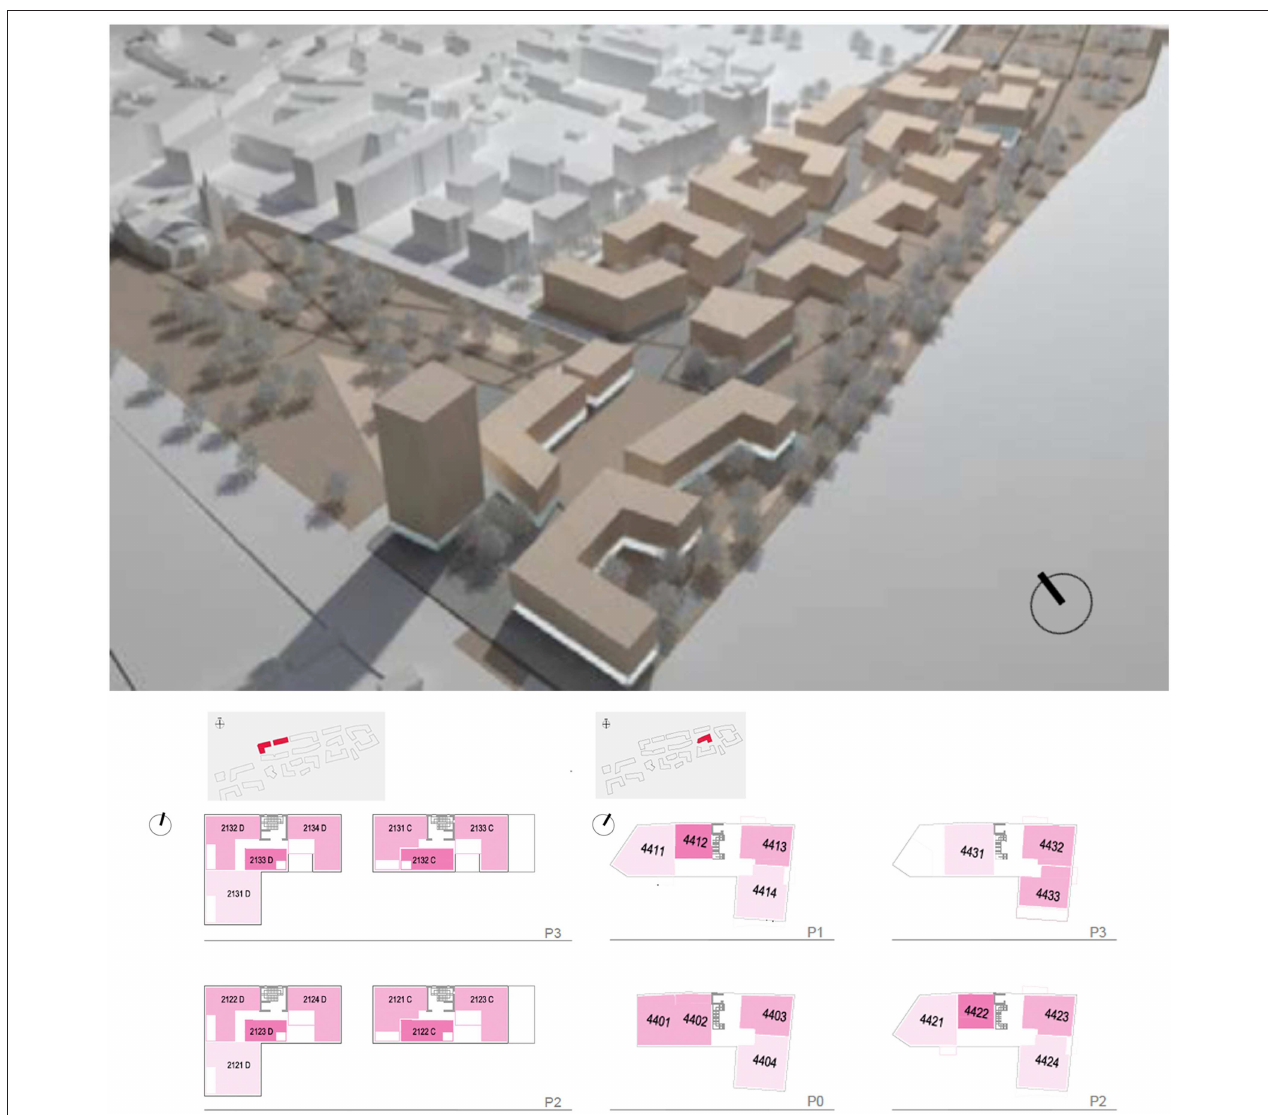
FIGURE 1 | Schematic view of the social housing intervention and layout of some